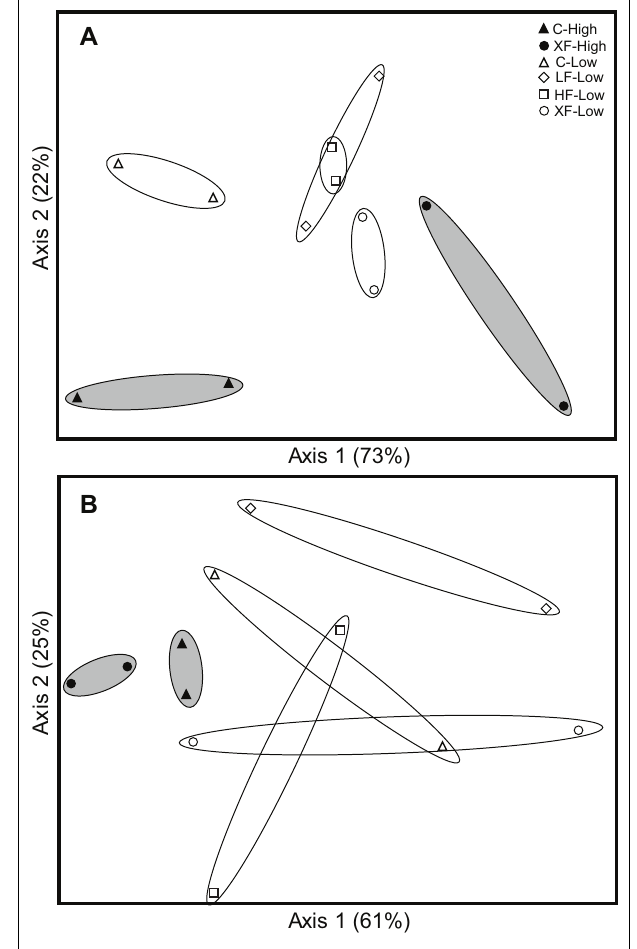
FIGURE 2 | Non-metric multidimensional scaling ordinations based on TRFLP profiles for betaproteobacterial amo A genes (A) and archaeal amo A genes (B). Low marsh samples are represented by open symbols; high marsh samples are represented by filled symbols. Polygons (white-filled for low marsh, gray-filled for high marsh) are drawn around replicate samples in each plot.The percent variability explained by each axis is indicated